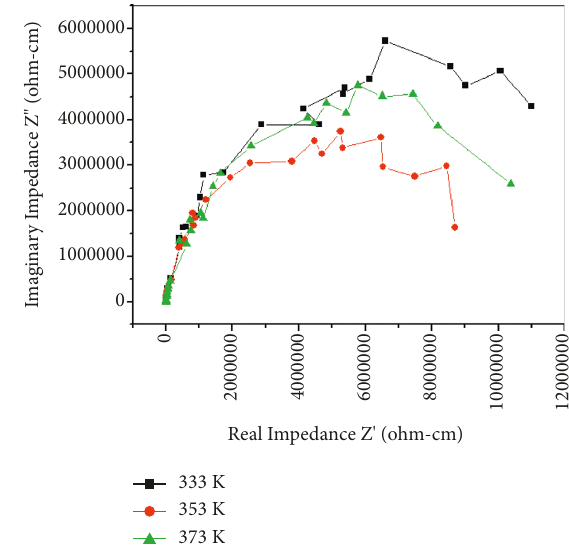
Figure 9: Real impedance vs imaginary impedance.